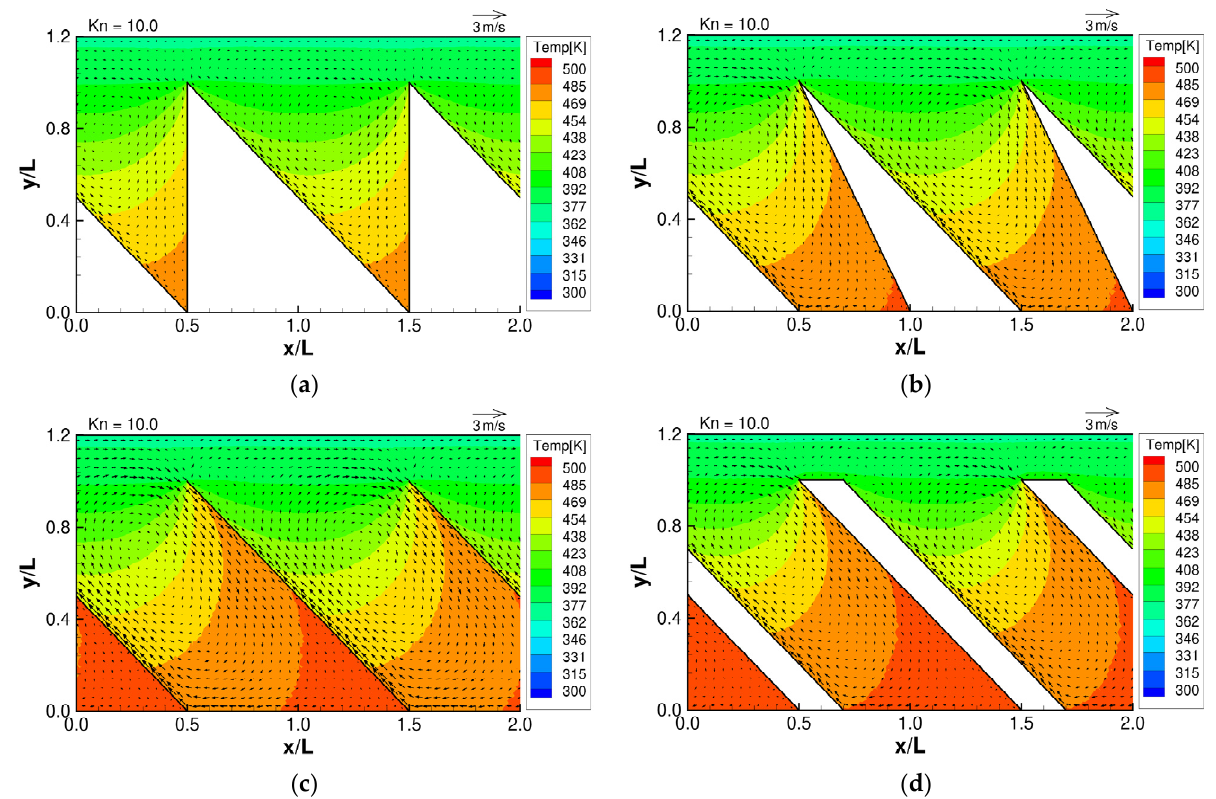
Figure 5. Flow distributions and temperature distributions for ( a ) ratchet, ( b ) modified ratchet, ( c ) oblique plate, and ( d ) oblique ridge, at Kn = 10 .